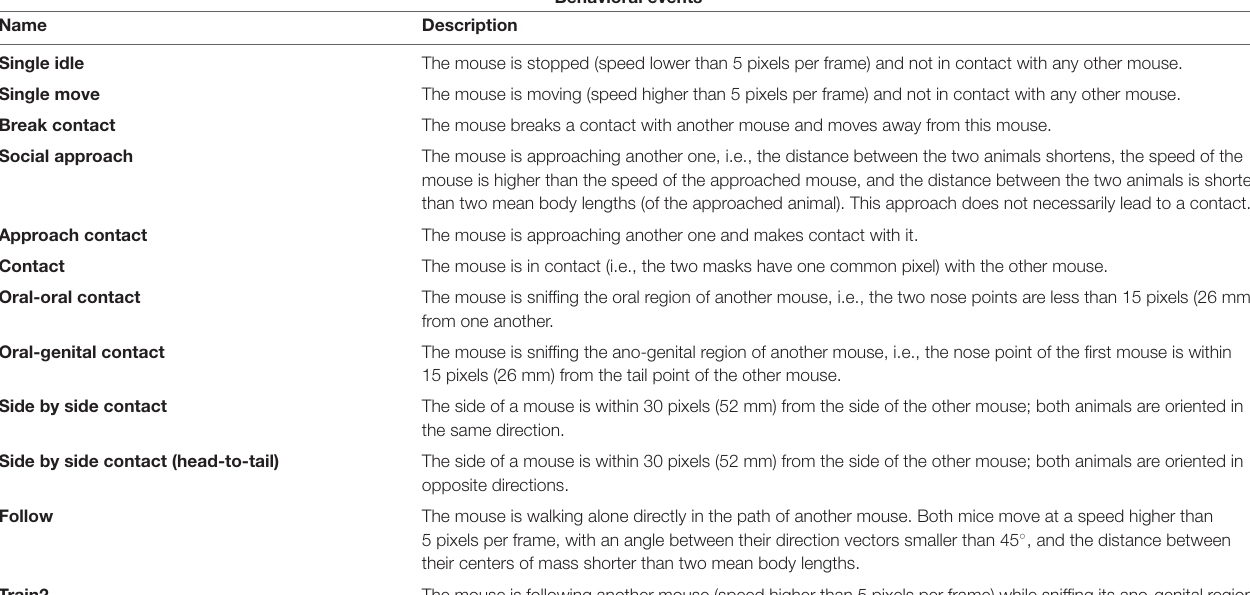
TABLE 1 | Definitions of behavioral events extracted by Live Mouse